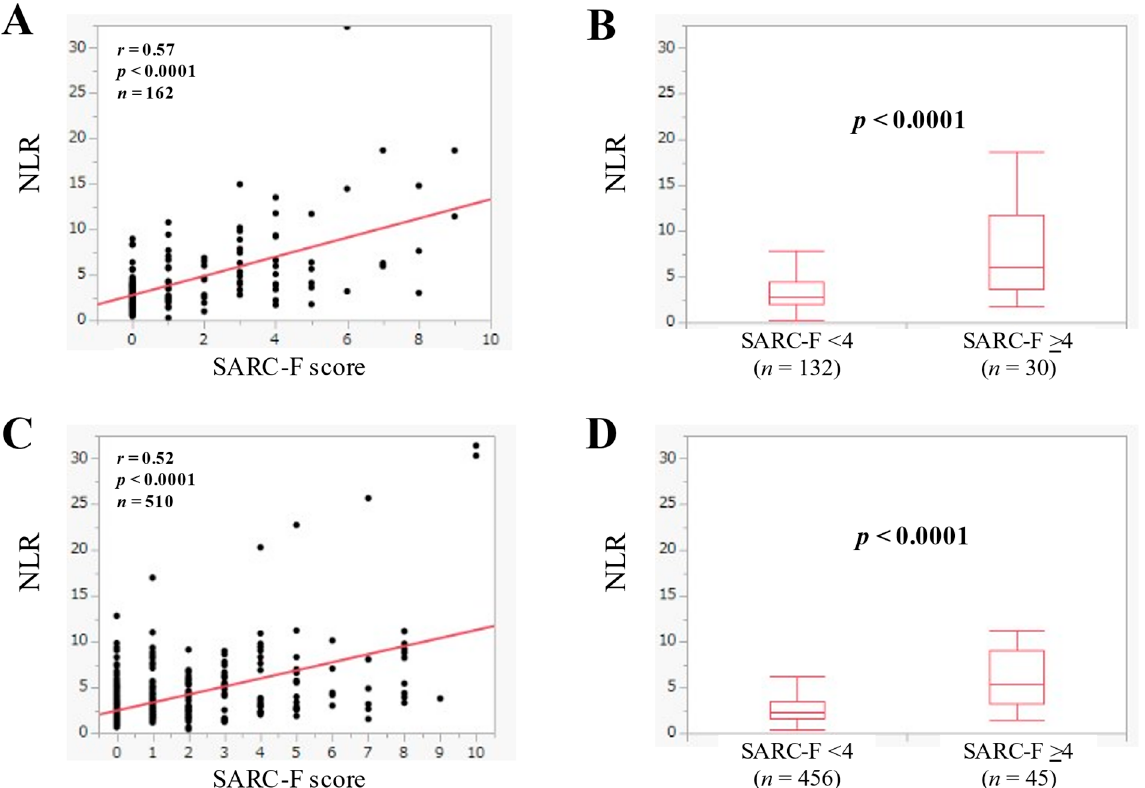
Figure 5. ( A ) The relevance in the NLR and the SARC-F score in advanced cancer cases ( n = 162). ( B ) Comparison of NLR between SARC-F <4 ( n = 132) and ≥ 4 ( n = 30) in advanced cancer cases. ( C ) The relevance in the NLR and the SARC-F score in non-advanced cancer cases ( n = 510). ( D ) Comparison of NLR between SARC-F <4 ( n = 456) and ≥ 4 ( n = 45) in non-advanced cancer cases.